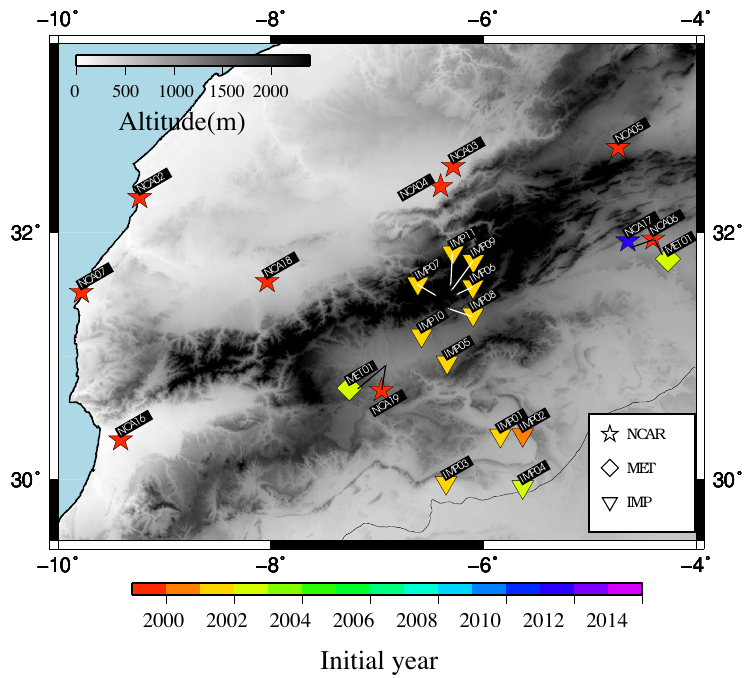
Figure 1. Distribution of 10-min wind and wind gust observational sites. NCAxx (stars) stands for the sites provided by NCAR, METxx (diamonds) the data provided by Météo Maroc and IMPxx (inverted triangles) the data provided by the IMPETUS project. Color shading indicates the first year of the records at each site. “ xx ” denotes the identification label of each site (i.e., NCA 02 , NCA 03 ,